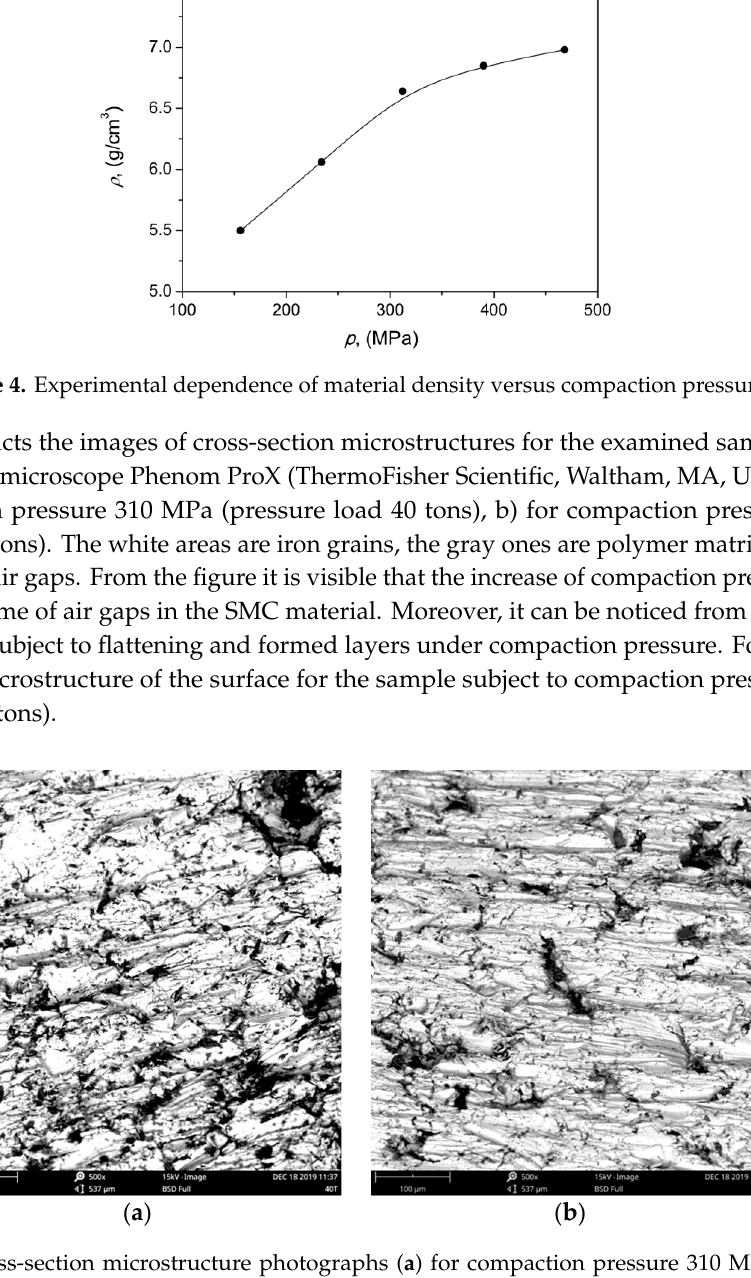
Figure 4. Experimental dependence of material density versus compaction pressure.